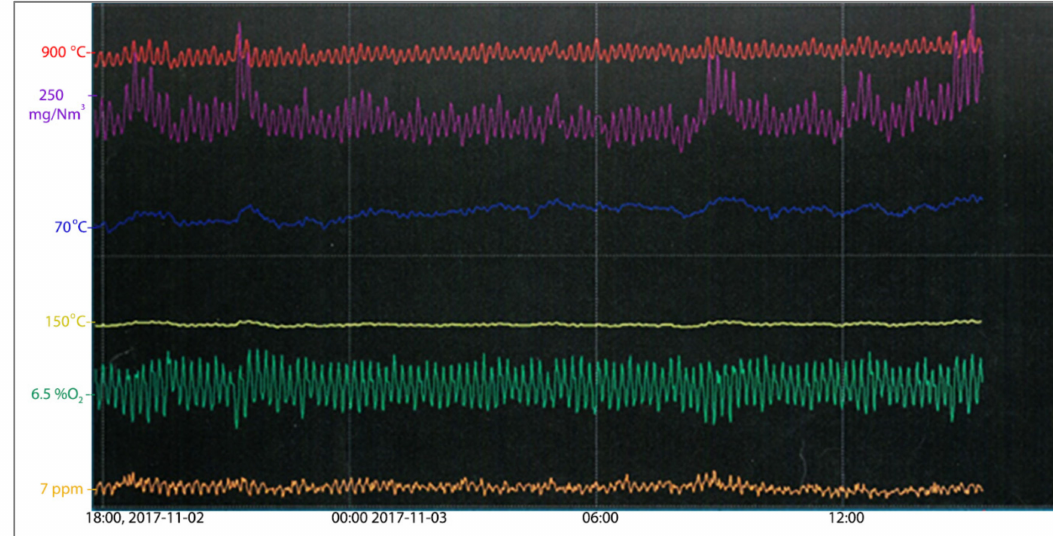
Figure 3. Trend curve of the stability in the operating conditions of the grate fired boiler. (cid:4) = District heating water temperature ( ◦ C); (cid:4) = Combustion chamber temperature ( ◦ C); (cid:4) = Oxygen in flue gas (% on wet flue gas); (cid:4) = Flue gas temperature after boiler section ( ◦ C); (cid:4) = Carbon monoxide (CO) (ppm on wet flue gas); (cid:4) = Nitric oxides (NOx) (mgNO 2 / m n3 in dry flue gas). Due to the high temperatures during the char burnout on the grate, significant slag formation was observed, Figure 4, for the mixed fuel sample MSS-SW 30–70 but not for the reference case with only SW. The bottom ash samples for the mixed fuel therefore had to be crushed before they could be collected and divided into one representative bottom ash sample. This bottom ash sample of the fuel mixture had a P concentration of 49 g per kg ash, Table 6. The calculated concentration of P in the fuel mixture (Table 1) was 74.5 g per kg ash, which was considerably higher than the levels found in the bottom ash. The filter ash and multi-cyclone ash contained 81 g and 32 g P per kg ash respectively. Calculated P 2 O 5 concentrations in Tables 4 and 6 were in the range 9–16 wt.% for the mixtures at laboratory scale and 11 wt.% for the industrial-scale MSS-SW